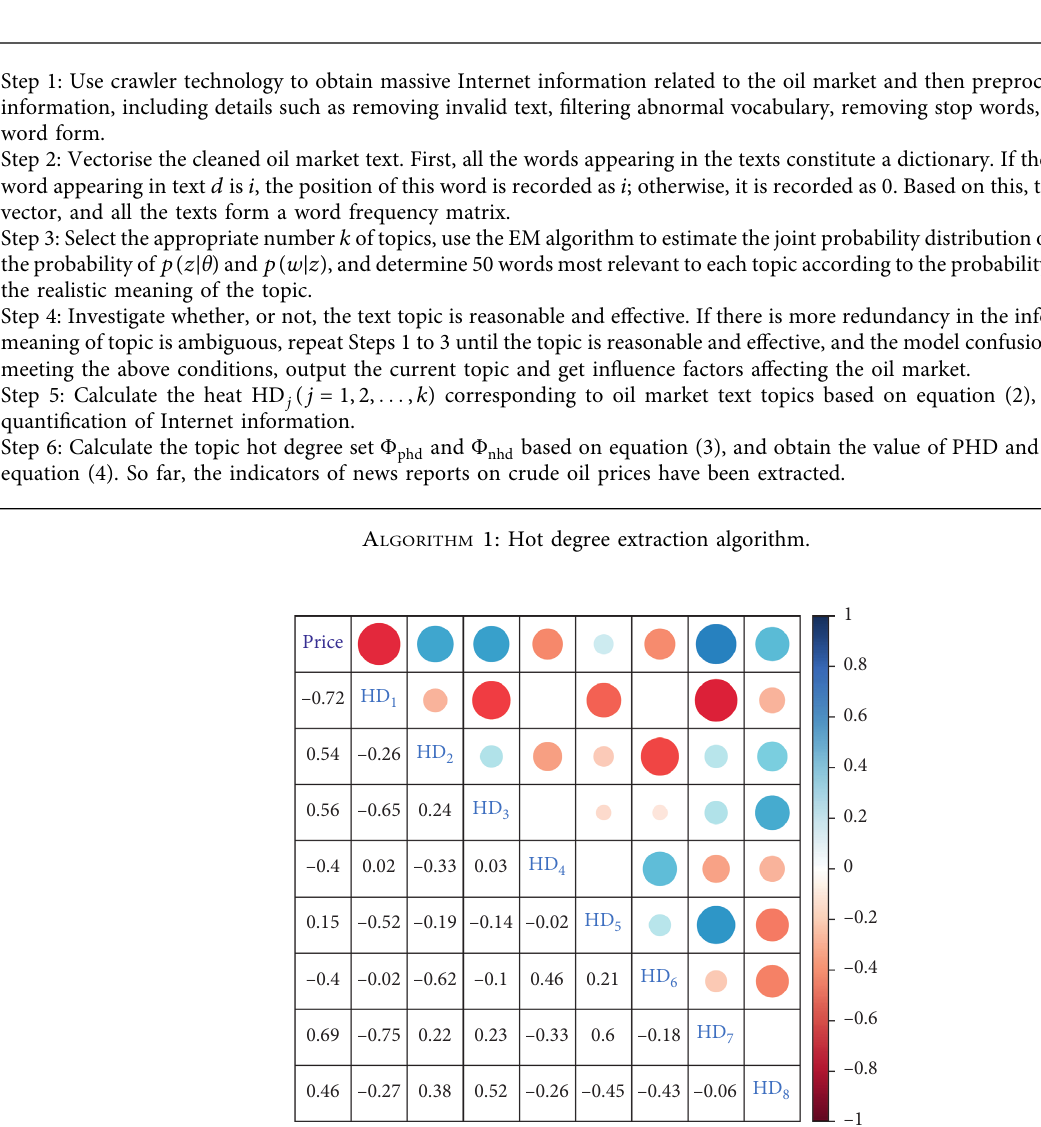
Figure 2: Correlation coefficient between oil prices and HD. Note: “price” represents Brent oil prices and “HD topic j